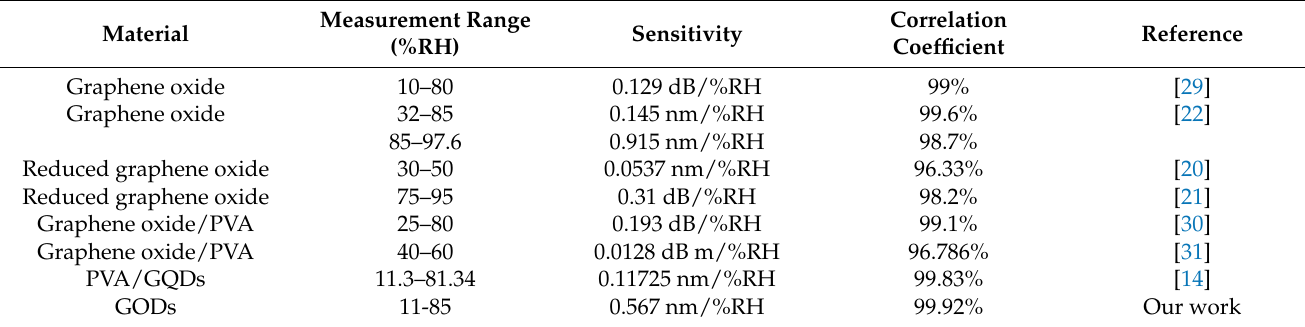
Table 2. Comparison of other optical fiber RH sensors based on different graphite